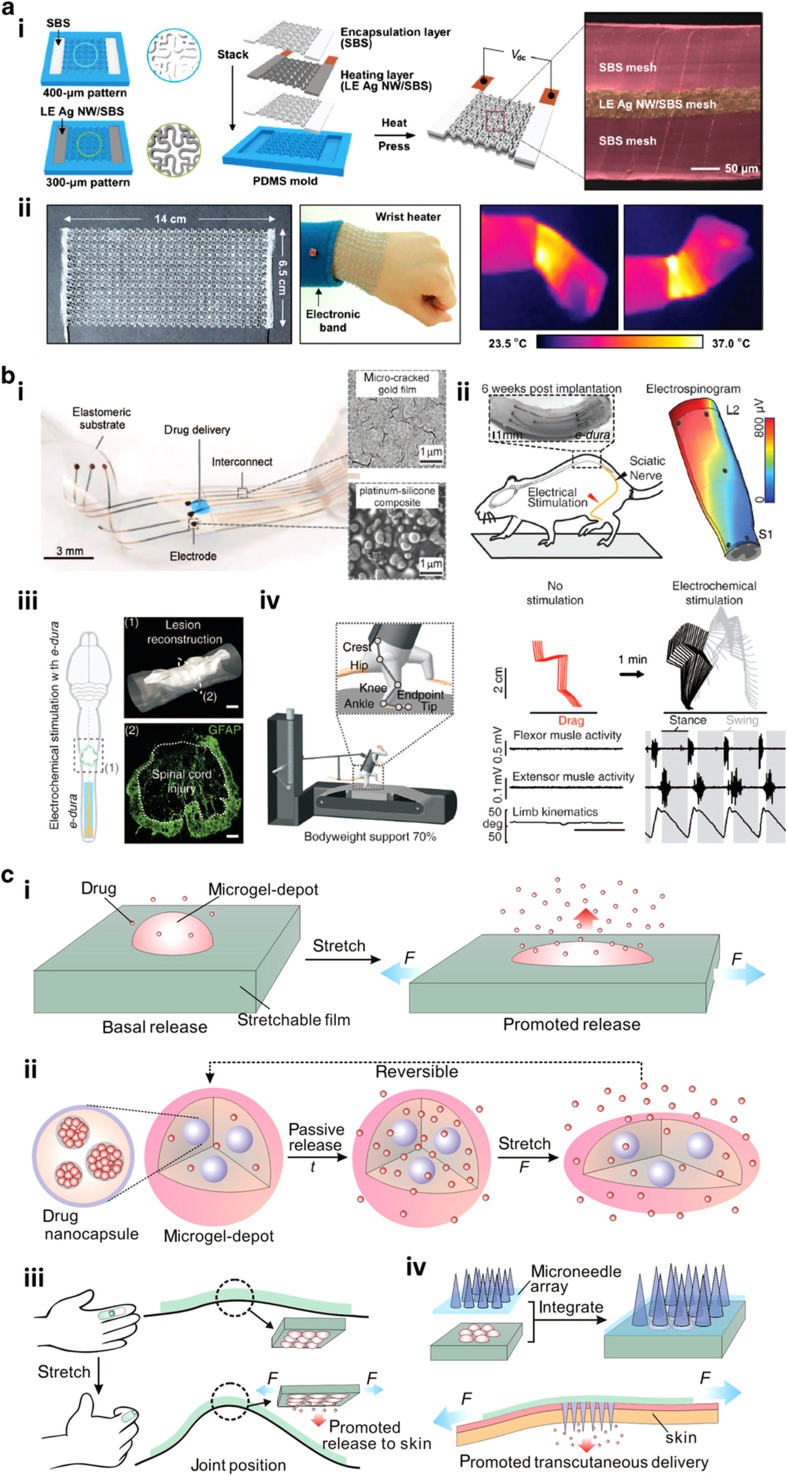
Flexible and stretchable physical sensing platforms for thermal therapy and drug delivery. (a) Stretchable and conformal mesh heating element for articular thermotherapy application. (i) Schematic illustration showing the fabrication process of the stretchable mesh heater, which comprised a heating layer of LE Ag NW/SBS elastomer composite and two encapsulation layers of SBS elastomers pressed together at high temperature. The colorized SEM image on the right shows the good interface between the three bonded mesh layers of SBS, LE Ag NW/SBS, and SBS. Scale bar, 50 μm. (ii) Optical image showing the large-area stretchable mesh heater (left). Optical image showing a wearable and portable heating system that integrated the stretchable mesh heater and a custom-made electronic band and the application of the integrated heating system on a wrist (center). Infrared camera images showing uniform heat distribution on the wrist (right). Adapted with permission from Ref. 48. Copyright 2015 American Chemical Society. (b) Soft elastic electronic dura mater or e-dura neural implants. (i) Optical image illustrating the fabricated e-dura implant and the accompanying SEM images of the stretchable gold interconnects and platinum–silicone composite-coated soft electrodes. (ii) Implantation of the e-dura between the motor cortex tissues and the dura mater for 6 weeks (left) and the reconstructed spinal cord activation map in response to electrical stimulation of the left sciatic nerve based on the recorded electrospinograms (right). (iii) Spinal cord injured rats with implanted spinal e-dura over the lumbosacral sections. (iv) Recording of the bipedal locomotion of the rat under support after 3 weeks of rehabilitation in the absence and presence of electrochemical stimulation and corresponding stick diagram decompositions of the hindlimb movements and oscillations and the leg muscle activities. Adapted with permission from Ref. 49. Copyright 2015 American Association for the Advancement of Science. (c) Wearable tensile strain-triggered drug delivery system. (i) Schematic illustration showing the two distinct components and the working mechanism of a strain-triggered drug delivery system in which deformation of the stretchable elastomer promoted drug release from the microdepot. (ii) Schematic illustration showing the encapsulation of the drug-loaded nanoparticles within the microdepot and the passive release and partial retention of the drug-filled nanoparticles within the microdepot matrices. (iii) Conformal attachment of the wearable drug delivery system onto the index finger where drug release to the skin could be simply triggered by the finger flexion. (iv) Integration of the wearable strain-responsive drug delivery system with a microneedle array patch for the transcutaneous administration of drugs. Adapted with permission from Ref. 50. Copyright 2015 American Chemical Society.